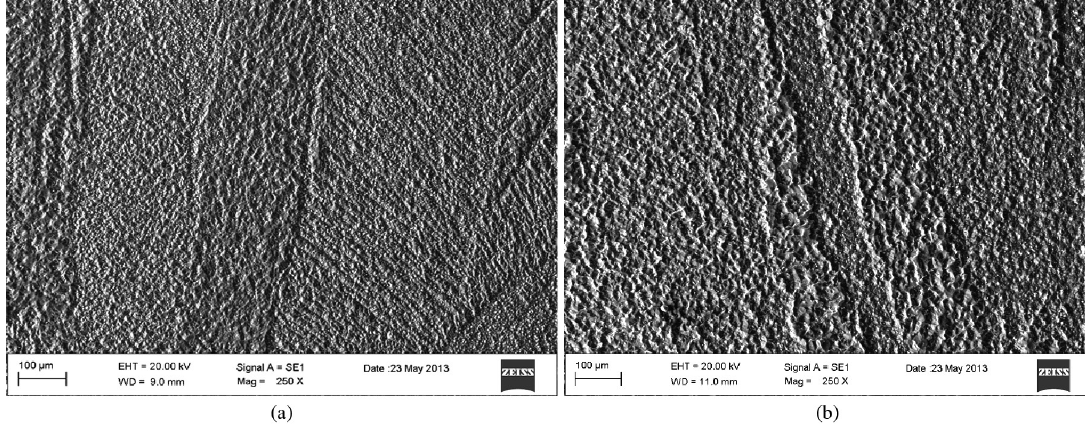
Figure 6. Microstructure detail of (a) H18 and (b) H24 conditions of AA1350 aluminum alloy, revealed in scanning electron